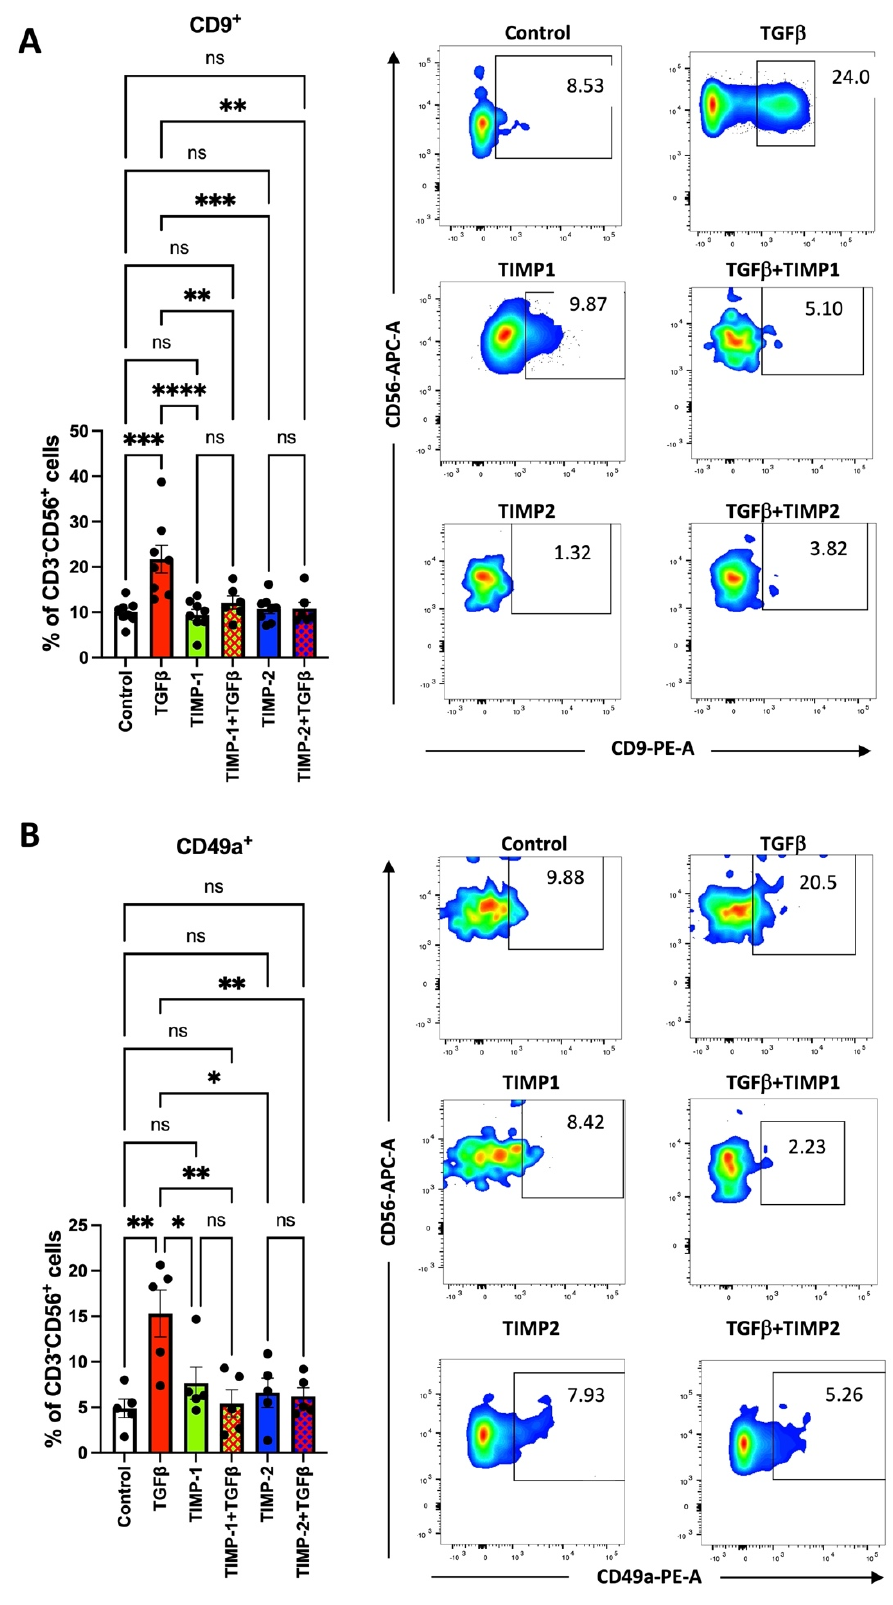
Figure 2. TGF β in the polarization of healthy donor-derived NK TIMP1 and TIMP2 cells lowers the CD9 (panel A ) and CD49a (panel B ) levels (dNK markers) induced by TGF β . Results are shown as mean ± SEM, ANOVA, ns = not signficant; * p < 0.05; ** p < 0.01; *** p < 0.005; **** p < 0.001. Representative plots are shown. Controls were cells in RPMI medium alone.